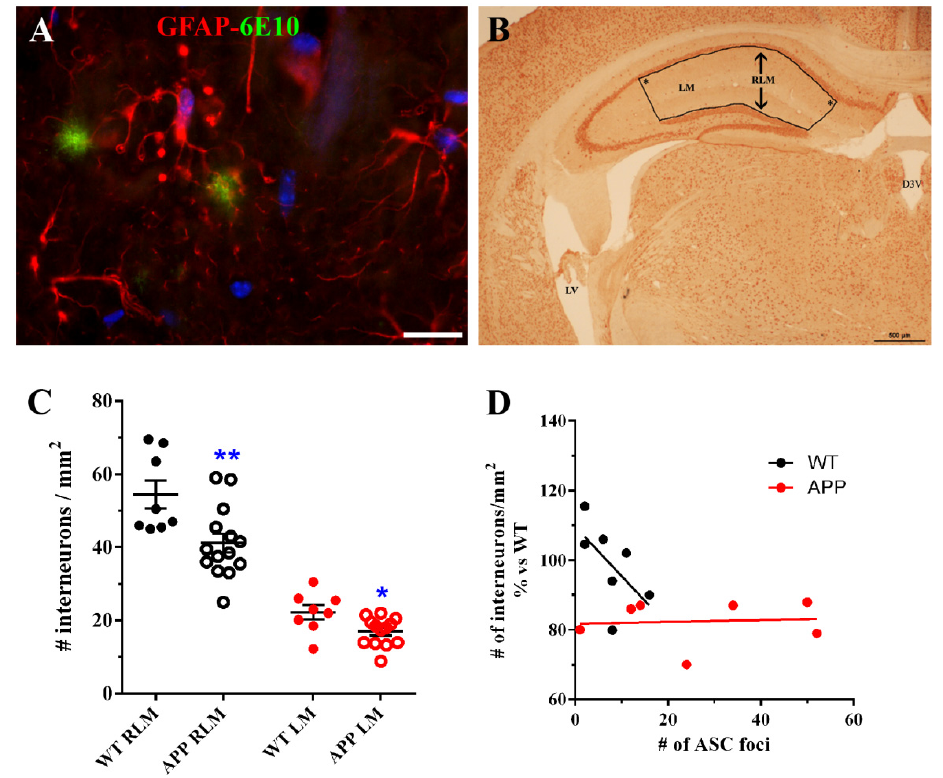
Figure 6. The number of interneurons per mm 2 localized in the strata RLM of HP is significantly reduced in APP versus WT. This reduction is not correlated with the amount of ASC foci developed in these regions. ( A ) shows a representative specific astrocyte associated to diffuse A β deposits, with spherical process terminals in proximity to diffuse A β deposits. ( B ) shows a representative coronal section at ~ − 2mm of Bregma, showing the bounded area used for the quantification of NeuN-positive interneurons in the strata RLM or only in LM in 6 WT and 13 APP. D3V: dorsal third ventricle, LV: lateral ventricle, *right angles in the bounded area (see methods). ( C ) shows this quantification as a scatter plot, where each value represents the mean ± SEM of interneuronal densities from both hippocampal hemispheres of each analyzed coronal section. Note the significant reduction of interneurons in APP both in RLM and LM. ( D ) shows that there is no correlation between the density of interneurons in RLM and the number of foci/section developed in 7 APP with the highest number of ASC foci. By contrast, in 7 WT there is an inverse correlation between both parameters, though the number of foci is smaller. In C and D the symbol # represents the number of interneurons and ASC foci. Student´s test. * p ≤ 0.05 and ** p ≤ 0.01 vs. WT. Scale bars represent 20 µm in ( A ) and 500 µm in ( B ).